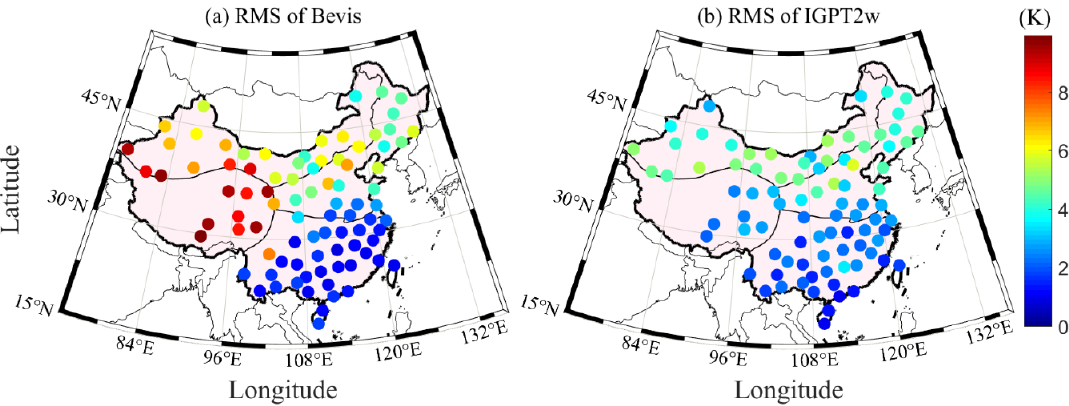
Figure 6. RMS distributions of T m differences derived from Bevis and IGPT2w at 87 radiosonde stations when the RS-derived T m is considered as the reference.